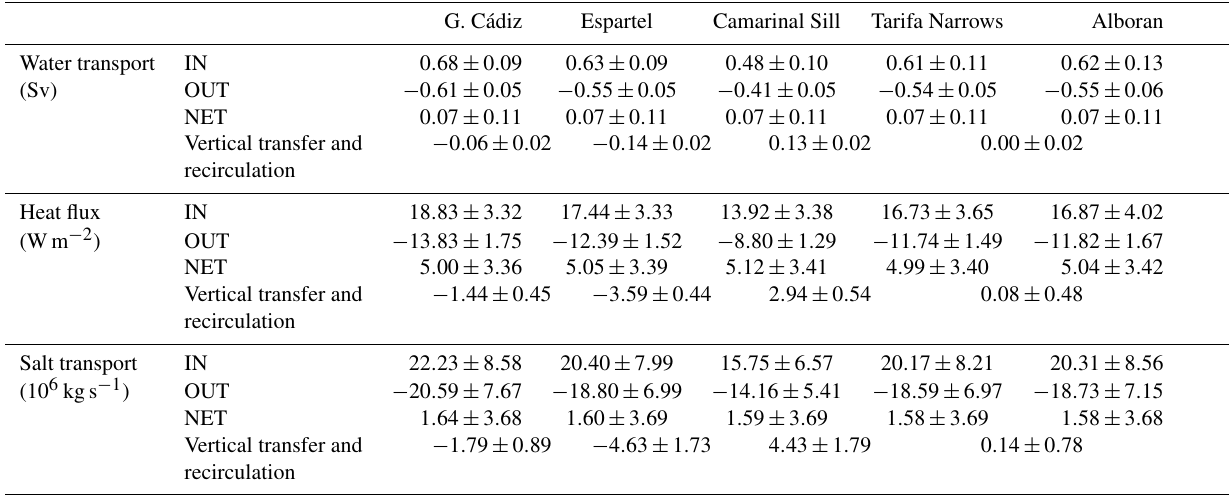
Table 5. As Table 4 but using monthly data computed from the tidal run. Values at the outer sections already reported in Table 1 are included here for